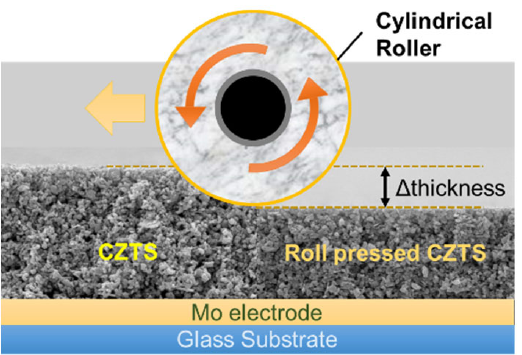
Figure 1. Compression process of the CZTS powder coat using a roll-press machine (Wellcos Corp., Rep Korea).